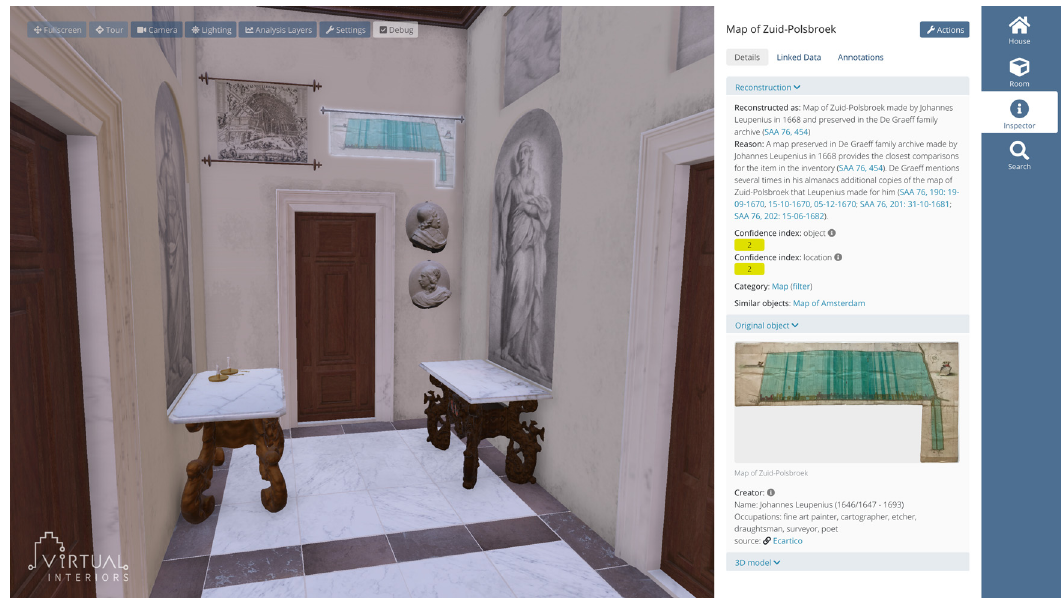
Figure 7: 3D research environment with selected map of Zuid -